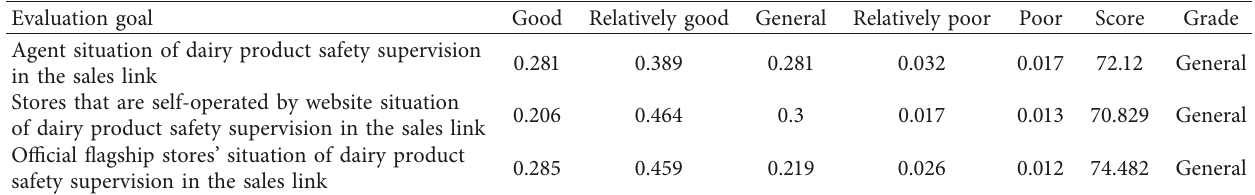
Table 10: Scores of the safety supervision of dairy products in the sales link for three types of online businesses 1 .